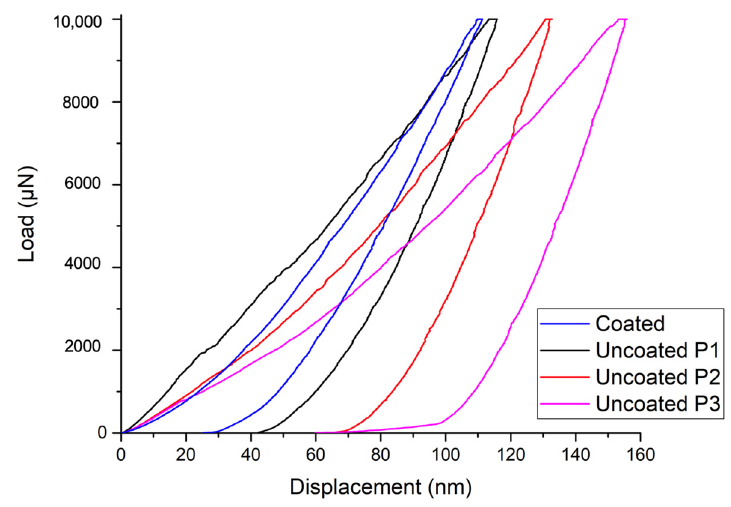
Figure 6. Loading–unloading curves of the coated and uncoated samples after nanoindentation tests.